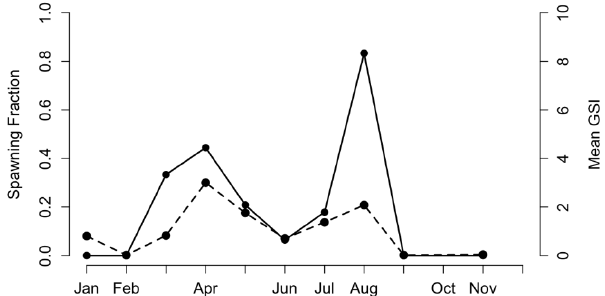
Fig. 6 . Comparison of gonadosomatic index (GSI) and spawning fraction to determine spawn timing in kole (goldeye surgeonfish, Ctenochaetus strigosus ) through monthly mean GSI and spawning fraction to assess the spawning season for kole from Maunalua Bay in 2013. Dashed line represents GSI and spawning fraction is represented by a solid black